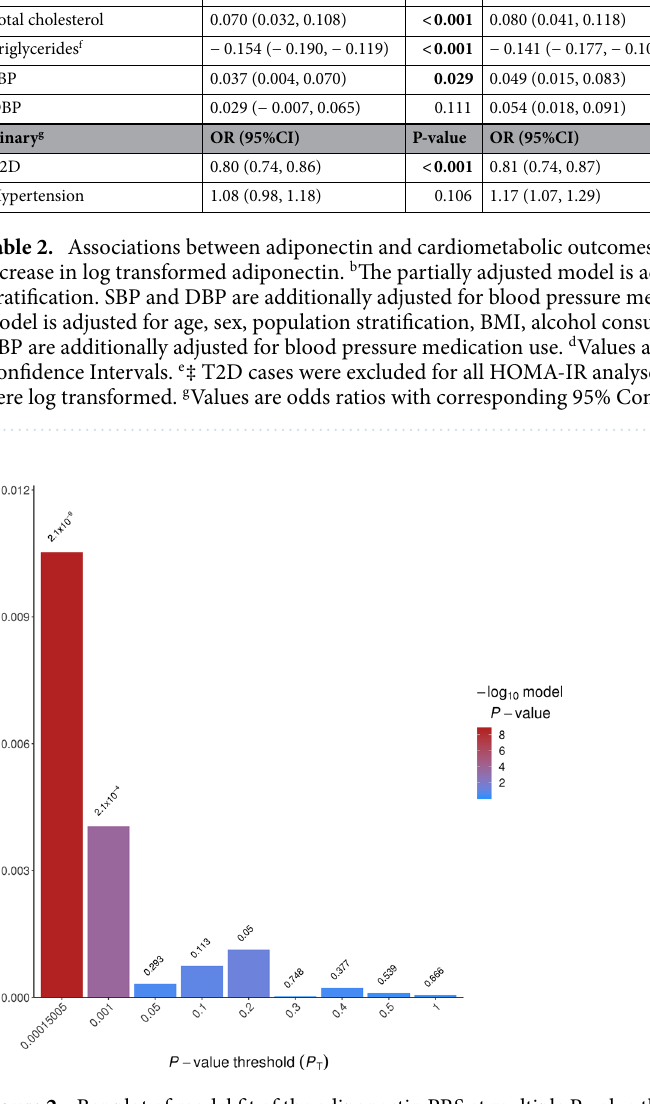
Figure 2. Bar plot of model fit of the adiponectin PRS at multiple P-value